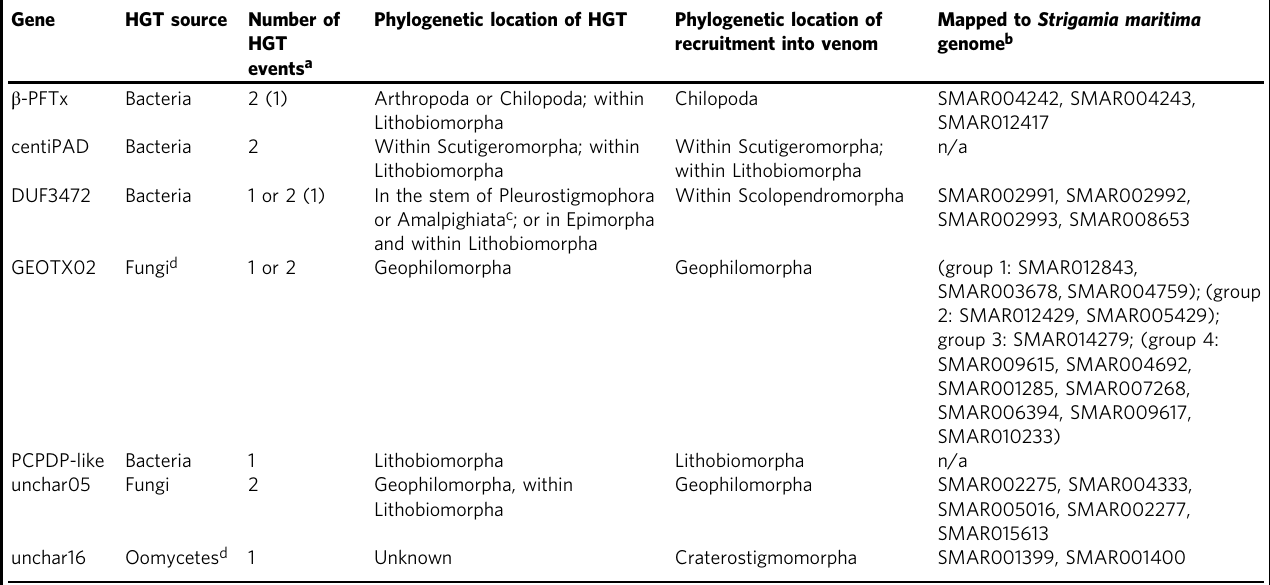
Table 1 Summary of gene families horizontally transferred into centipede